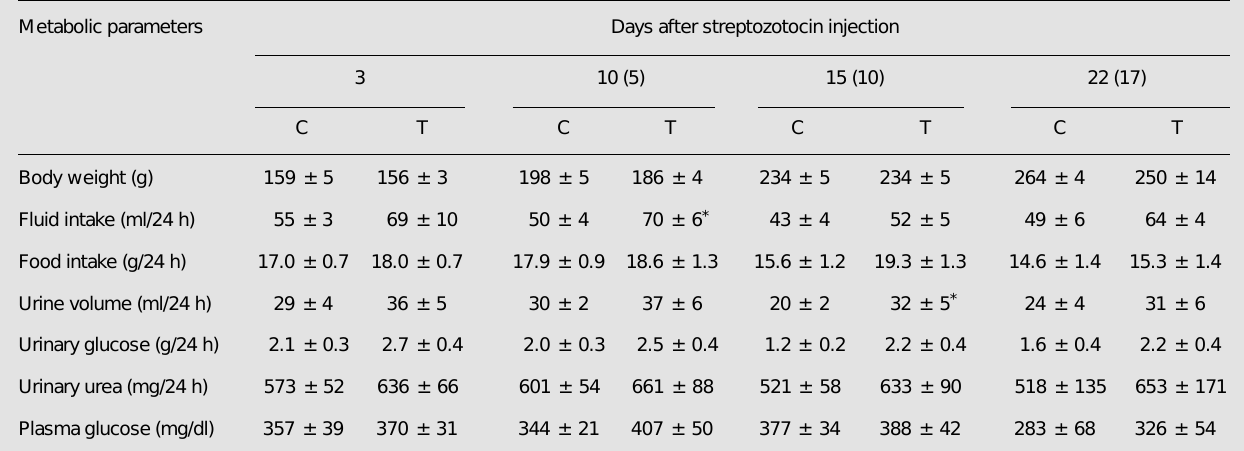
Table 1 - Metabolic parameters of streptozotocin (STZ)-diabetic rats during oral treatment with a decoction of Eugenia jambolana . The control group (C) of 10 rats received no decoction, while the treated group (T) of 10 rats received an aqueous E. jambolana leaf decoction in place of drinking water for 17 days. Rats were paired 3 days after STZ injection and treatment was started 5 days after STZ injection. The number in parentheses indicates the days of treatment. Except for body weight and plasma glucose, all values are reported per 100 g body weight. Data are reported as means ± SEM. *P<0.05 compared to control (ANOVA and unpaired Student t